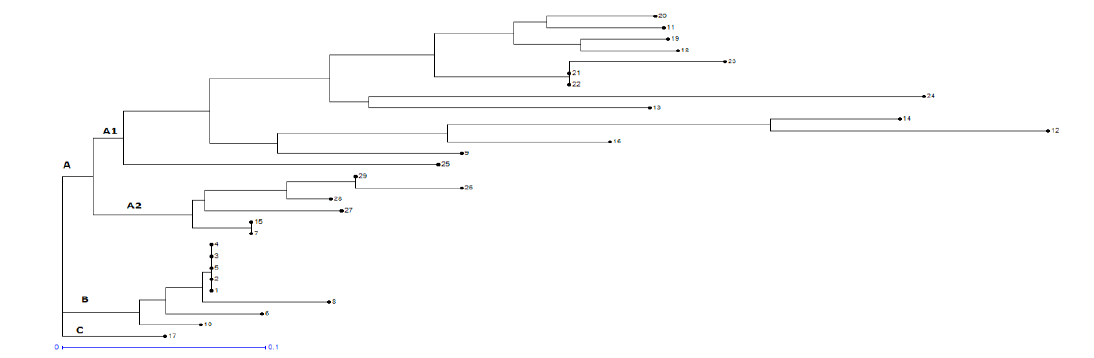
Figure 4. Dendrogram generated by hierarchical clustering method based on unweighted neighbor joining algorithm and Dice correlation coefficient, showing the genetic similarity among K. pneumoniae isolates by Random amplification of polymorphic DNA(RAPD) typing method.